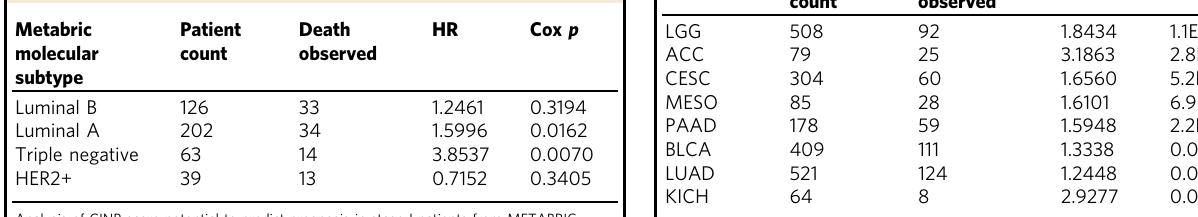
Table showing results from Kaplan – Meier and hazard ratio analysis across all cancer types in TCGA, where the CINP gene score is signi fi cant predictor of prognosis ( p <